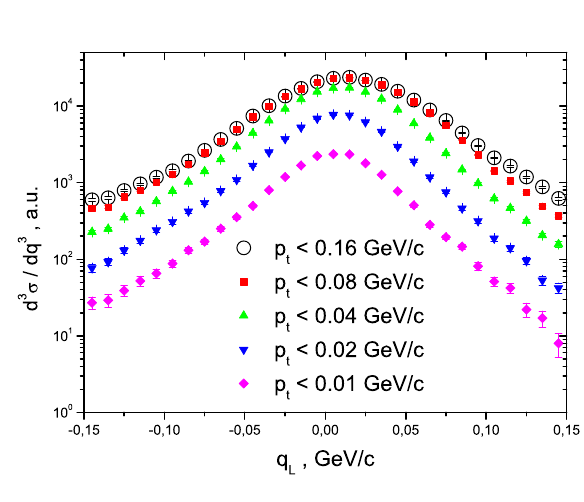
Figure 3. 12 C ( d , p ) X spectra in di ff erent p t -corridors